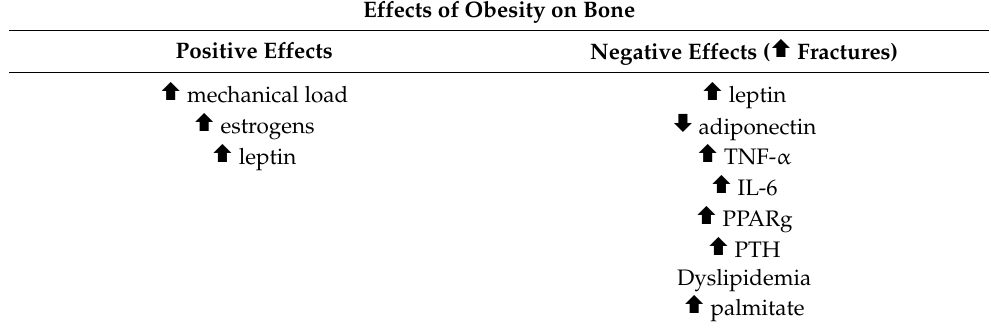
Table 1. Schematic representation of the positive and negative effects of various substances in the obese patient. As can be seen, the increase in Leptin can have both a positive and a negative effect, although it is the latter that prevails. TNF α and IL-6 are produced in excess due to the dysmetabolic action of obesity, but also adiponectin, as indicated by the arrow, leads to an increase of these inflammatory cytokines.